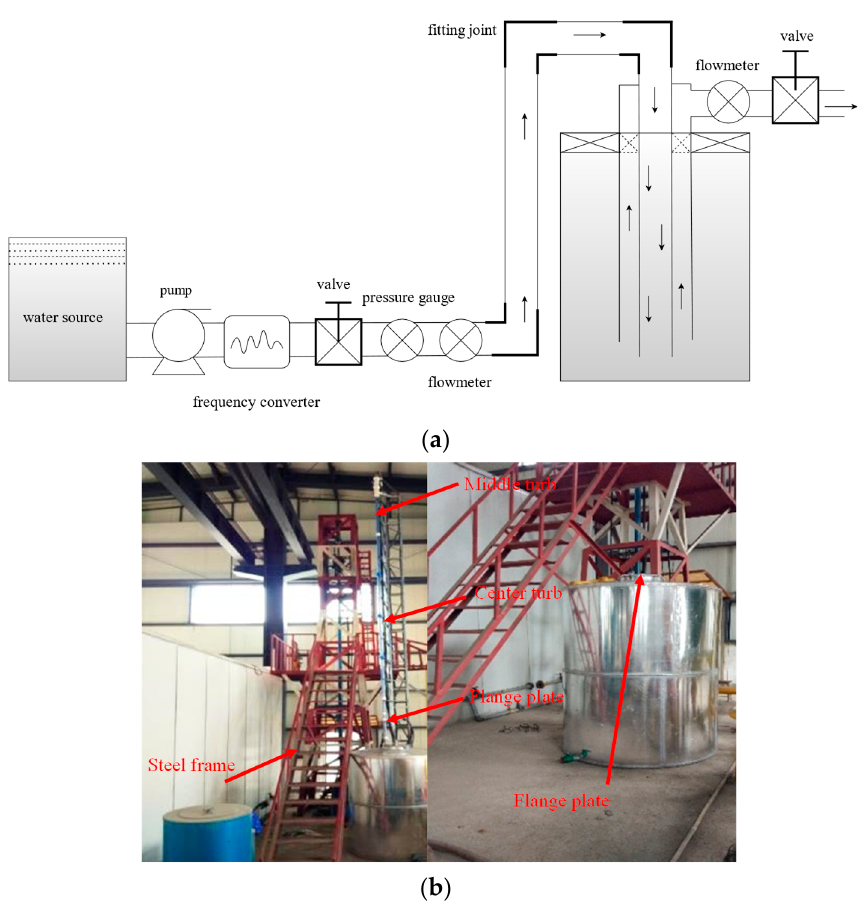
Figure 3. Schematics of the experimental device. ( a ) Theoretical diagram; ( b ) physical map.